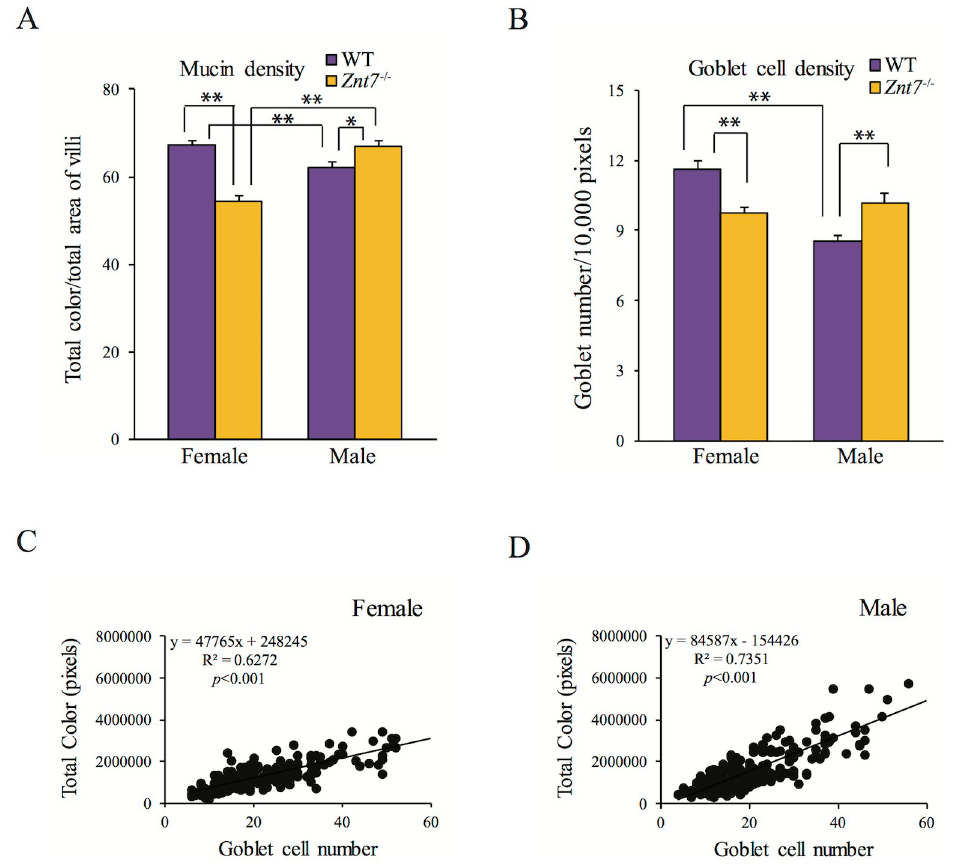
Fig 3. Sex specific differences in mucin density and goblet cell numbers in the colon. (A) Quantification of mucin density measured by Alcian blue/PAS staining in the villi of male and female WT and Znt7 -/- mice. (B) Goblet cell numbers in the villi of the same mice. (C and D) Correlation of mucin density measurement with goblet cell numbers from females and males, respectively. Total color in pixels represents the sum of magenta, blue, and purple intensities, as described in Fig 2, to represent total mucin content. All values are expressed as mean ± S.E. ( error bars ), n = 15–18 villi from 5–6 mice/sex/genotype. � , p < 0.05; �� , p < 0.01.